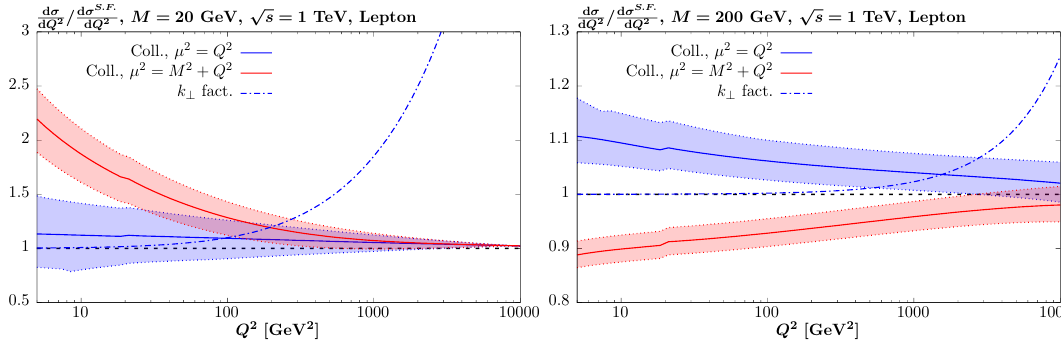
Figure 4 . Ratio of the di(cid:11)erential cross sections with respect to the photon virtuality, Q 2 , for heavy lepton (with mass M ) production calculated within the approximate collinear approach (3.13), to the structure function result (3.4). Results for di(cid:11)erent choices of factorization scale are shown, with the band corresponding to variations in the factorization/renormalization scales as above. The prediction within the k ? factorization approach is also shown. The two (cid:12)gures correspond to di(cid:11)erent choices of lepton mass, as